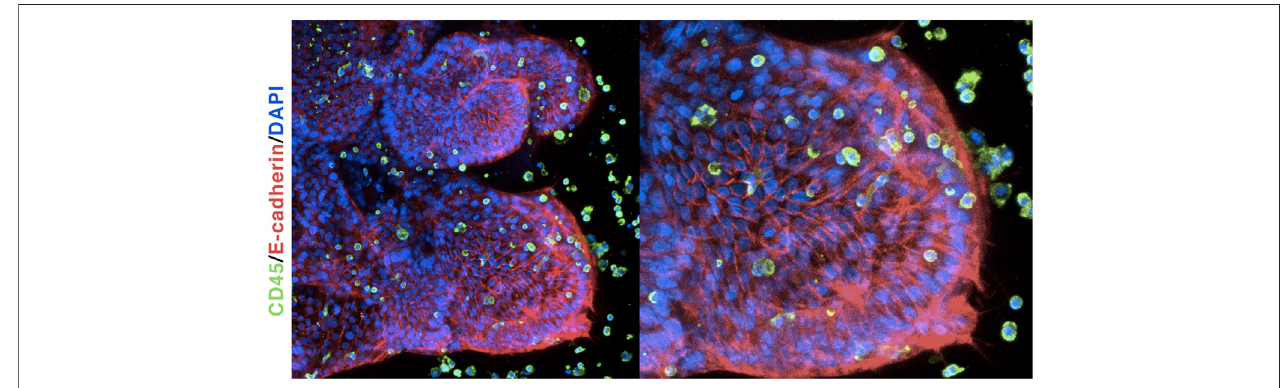
FIGURE 5 | Lung organoids co-cultured with primary monocytes: Immuno fl uorescent labeling of human LOs shows tissue polarity and recruitment of human monocytes.